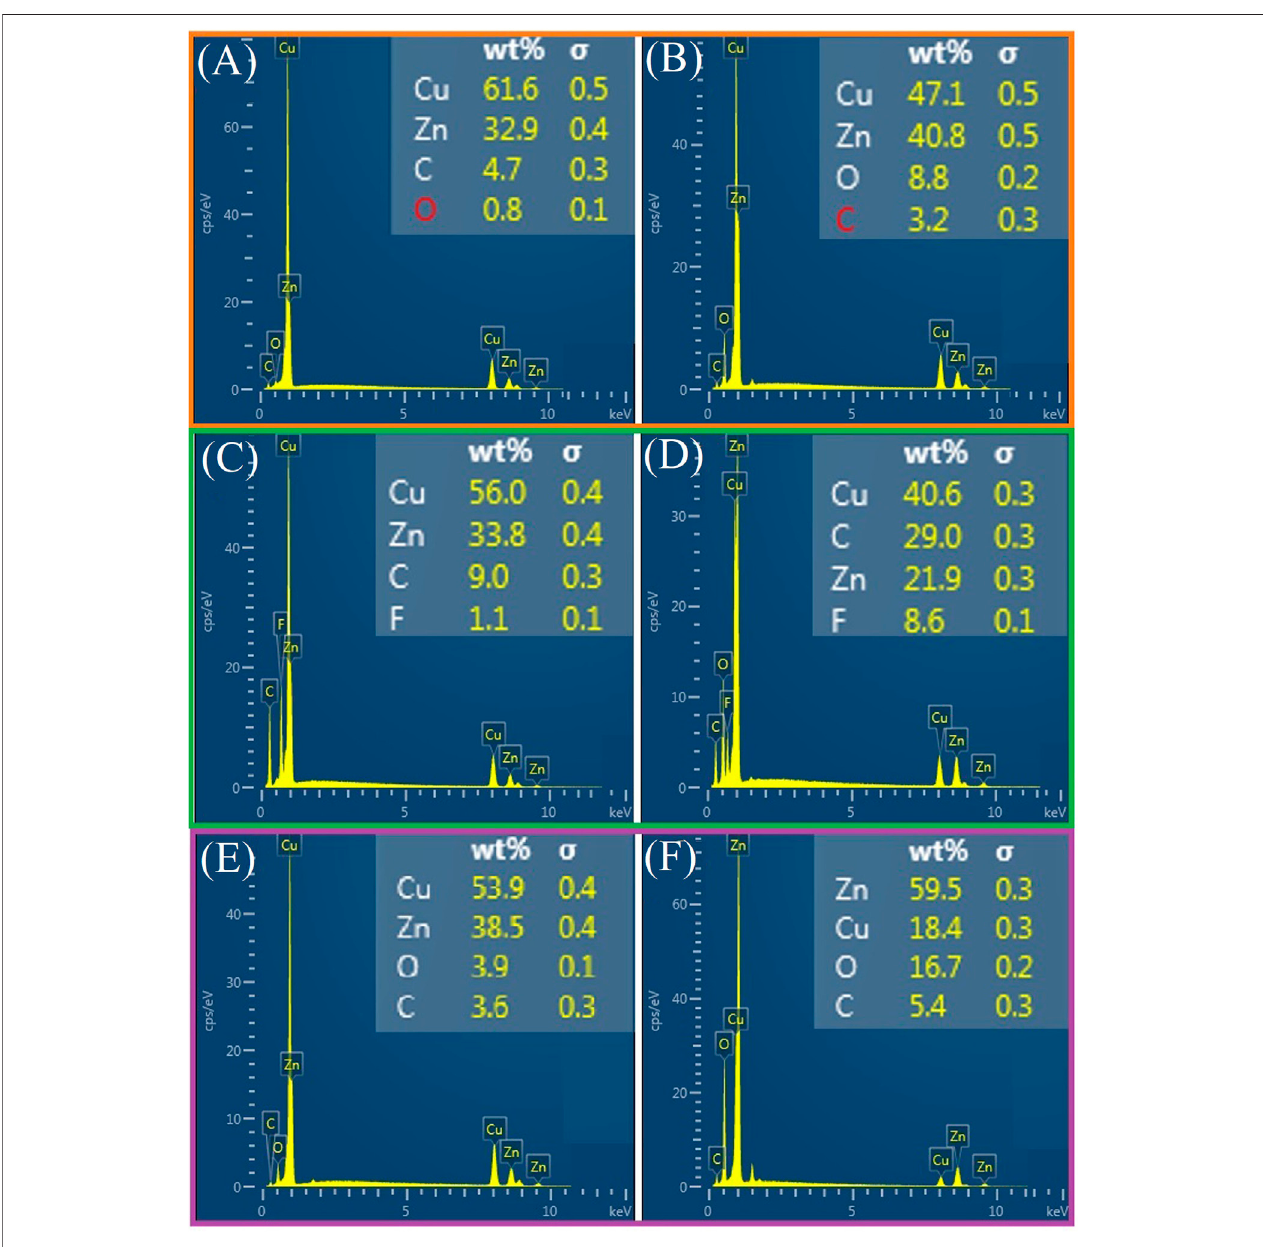
FIGURE 4 | EDS spectra for different treated samples. (A) The main elements of pristine copper. (B) The main elements of copper mesh after LT. (C) The main elements of copper mesh after CT. (D) The main elements of copper mesh after LCT. (E) The main elements of copper mesh after TO. (F) The main elements of copper mesh after